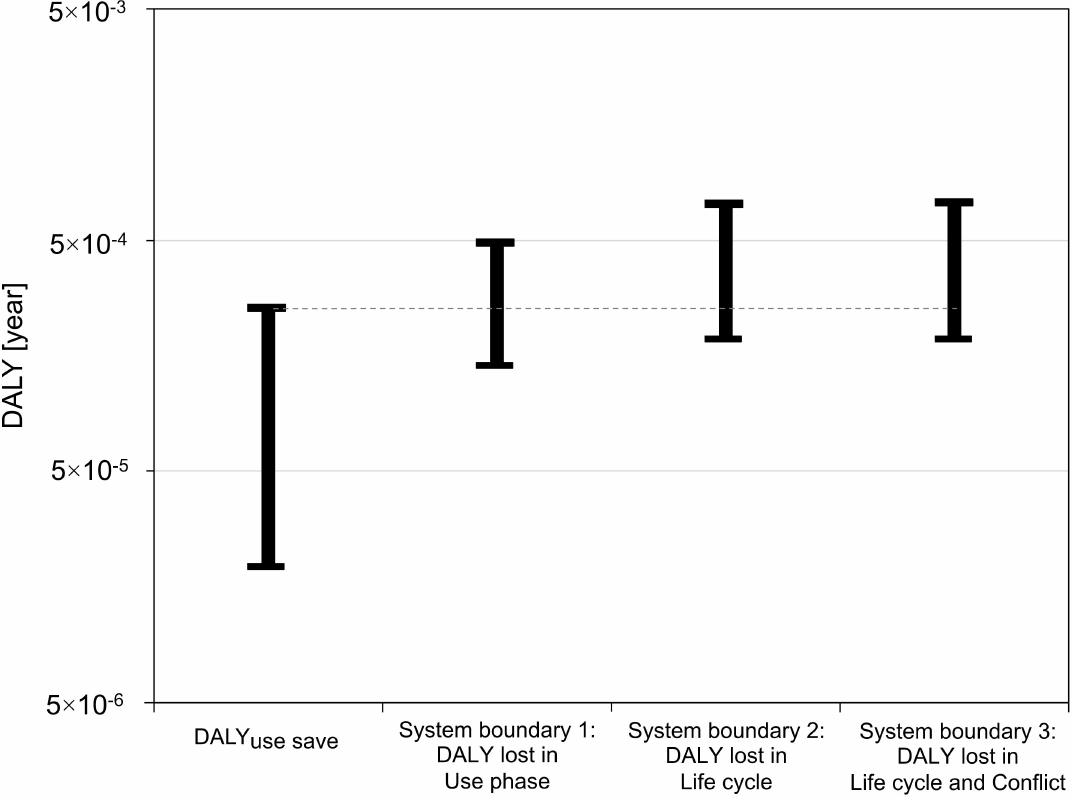
Figure 2. Results per tire studs in a studded passenger car used in Scandinavia, for the three system boundaries. DALY use save = years saved by using studded tires instead of non-studded winter tires during